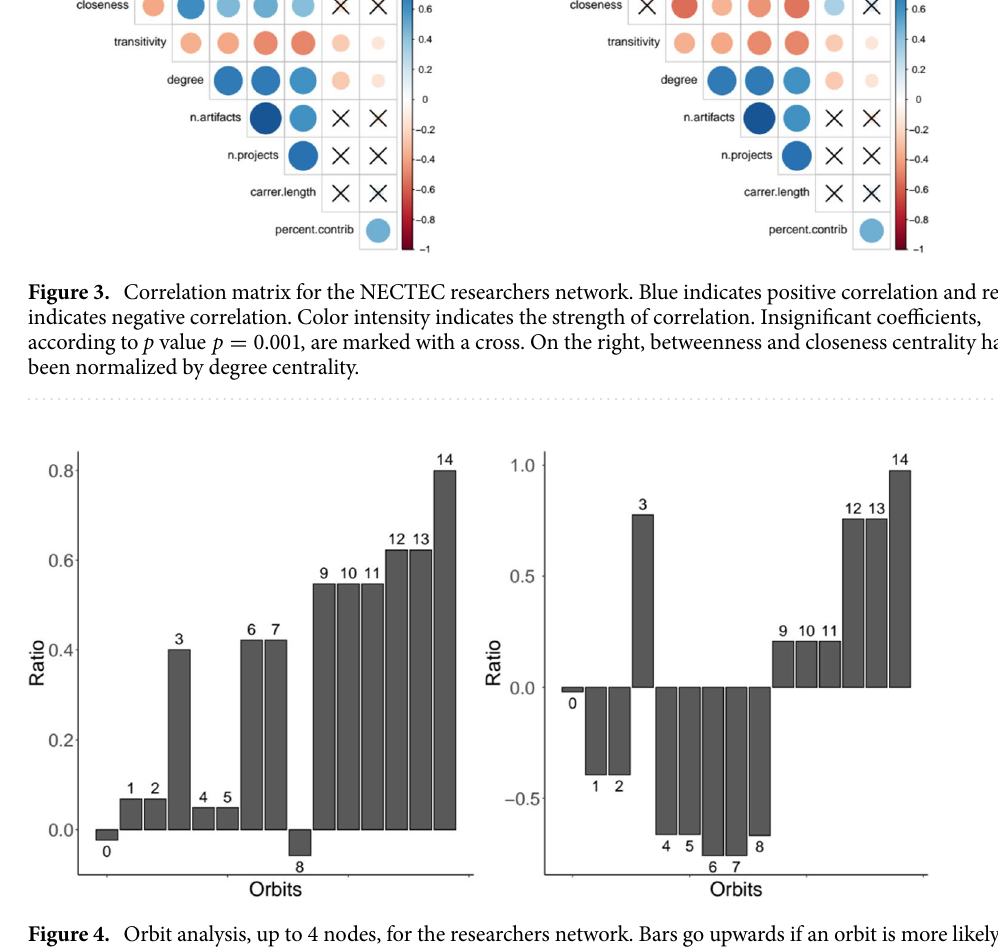
Figure 4. Orbit analysis, up to 4 nodes, for the researchers network. Bars go upwards if an orbit is more likely to be found in the real network compared to the null model. Left uses the Watts–Strogatz model as null model, while right uses Barabási